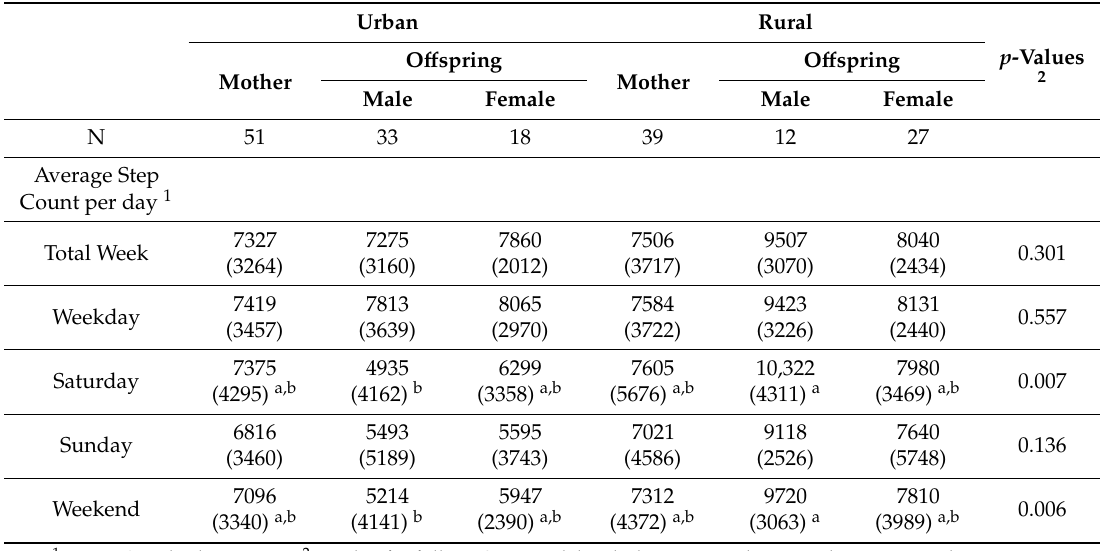
Table3. DailystepcountsofChineseparentsando ff